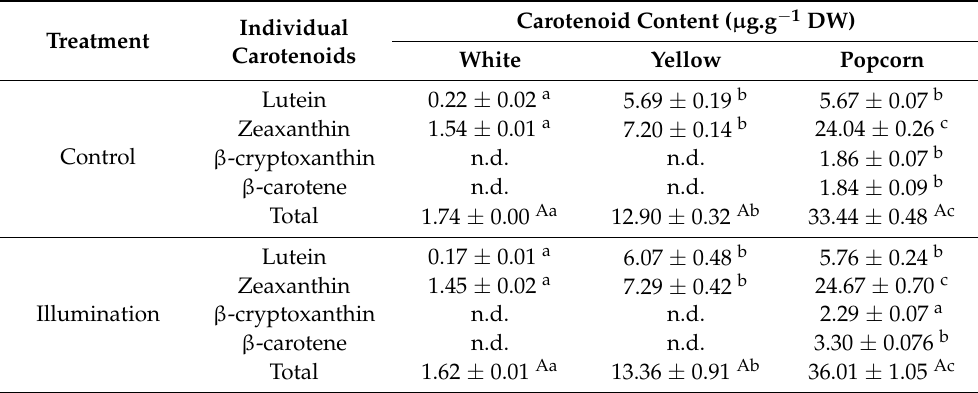
Table 2. Carotenoid content in the studied maize varieties (white, yellow and popcorn) before and after illumination using LED blue light at 130.3 J · cm − 2 .